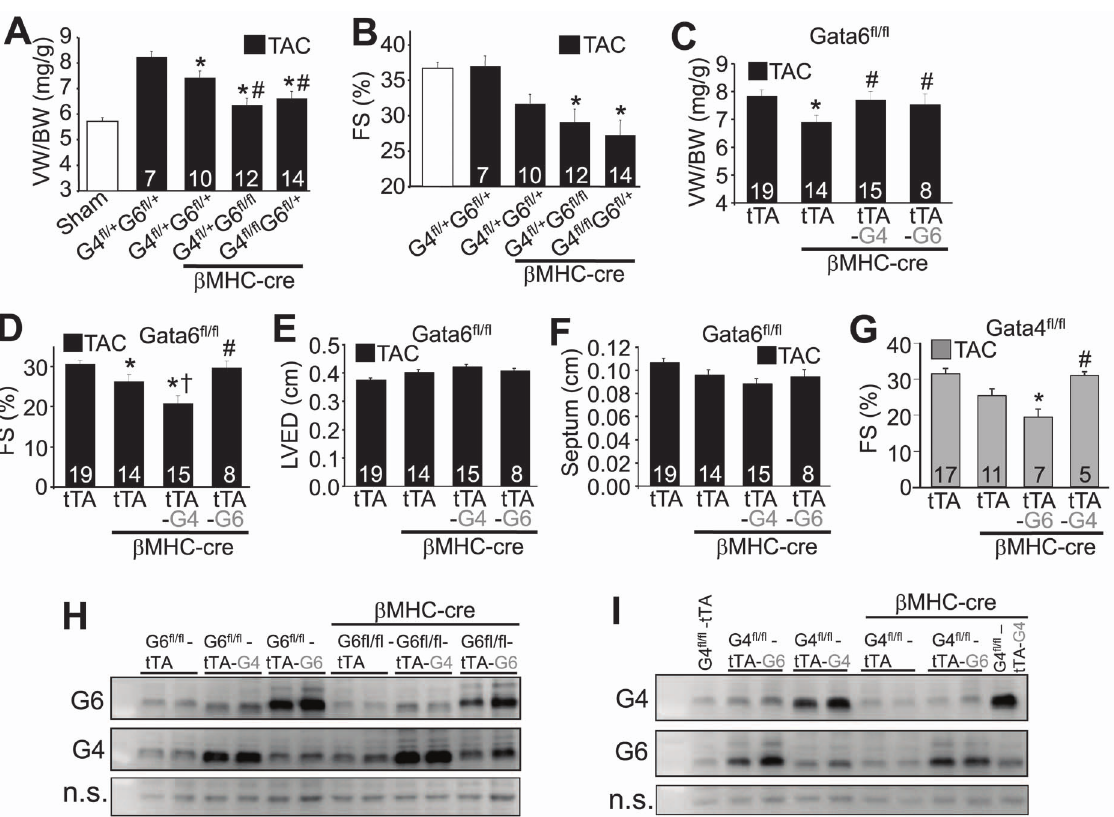
Figure 2. GATA-4 and GATA-6 play redundant roles in programming cardiac hypertrophy but not in adapting functional compensation. A, Ventricular weight to body weight (VW/BW) in the indicated genotypes of mice at 10–12 weeks of age following 2 weeks of TAC stimulation. The number of mice analyzed is shown in each bar of the graph. *P , 0.05 versus Gata4 fl/ + Gata6 fl/ + ; # P , 0.05 versus Gata4 fl/ + Gata6 fl/ + with the b MHC-cre transgene. B, Fractional shortening (FS%) from the indicated mice at 10–12 weeks of age following sham or 2 weeks of TAC stimulation. The number of mice analyzed is shown in each bar of the graph. *P , 0.05 versus Gata4 fl/ + Gata6 fl/ + with the b MHC-cre transgene. C, VW/ BW in the indicated groups of mice after 2 weeks of TAC stimulation at 10–12 weeks of age. The number of mice analyzed is shown in each bar of the graph. *P , 0.05 versus Gata6 fl/fl tTA transgene; # P , 0.05 versus Gata6 fl/fl- b MHC-cre tTA transgene. Abbreviations; tTA-G4, tetracycline transactivator transgene with the GATA-4 (G4) transgene; tTA-G6, tetracycline transactivator transgene with the GATA-6 (G6) transgene. D, Fractional shortening to measure ventricular performance of the same mice described in ‘‘C’’. *P , 0.05 versus Gata6 fl/fl tTA transgene; { P , 0.05 versus Gata6 fl/fl- b MHC-cre tTA transgene; # P , 0.05 versus Gata6 fl/fl- b MHC-cre tTA transgene or Gata6 fl/fl- b MHC-cre tTA transgene with GATA-4 transgene. E, F, Echocardiography measured left ventricular end diastolic dimension (LVED) and septal thickness in hearts of the indicated groups of mice after 2 weeks of TAC. G, Fractional shortening in Gata4 heart-specific, deleted mice with the additional transgenes shown after 2 weeks of TAC stimulation. Number of mice analyzed is shown in the bars. *P , 0.05 versus Gata4 fl/fl tTA transgene; # P , 0.05 versus Gata4 fl/fl- b MHC-cre tTA transgene with the GATA-6 transgene. H, I, Western blot analysis for GATA-4 (G4) or GATA-6 (G6) protein from the hearts of the indicated mice. A non-specific (n.s.) band from each of the western blots was used to show equal loading and running conditions.